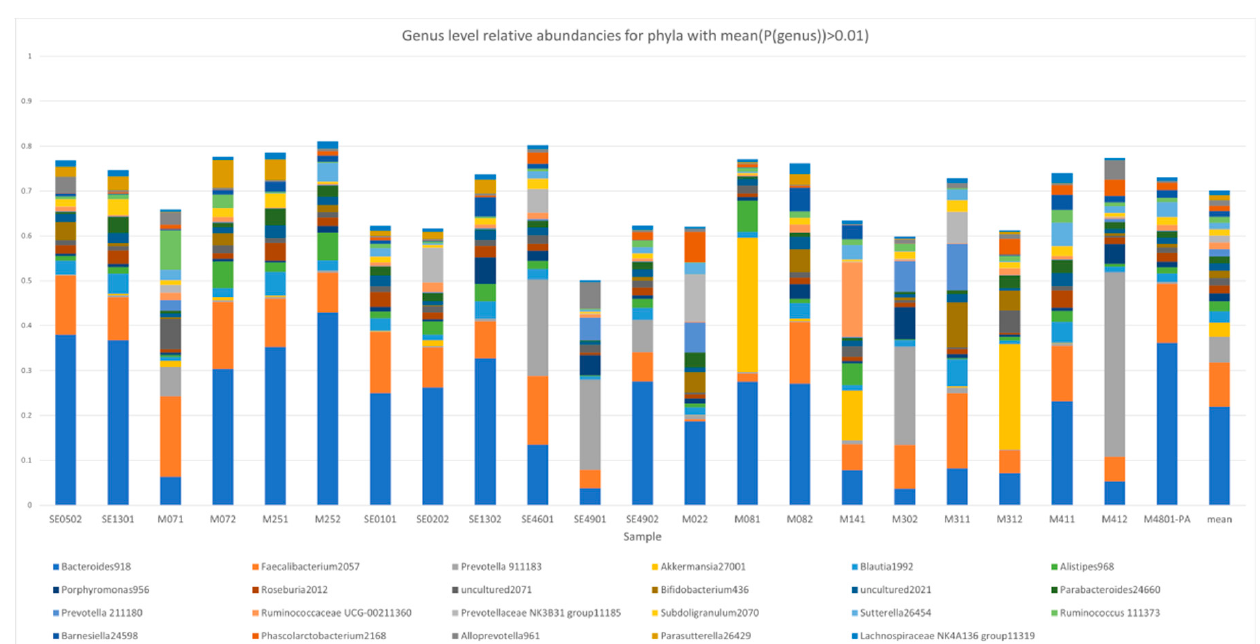
Figure 16. The relative abundances of bacteria at the genus level between the two groups. The first 6 columns are the subjects of the OSA − atherosclerosis group, and the next 16 columns are the subjects of the OSA + atherosclerosis group.